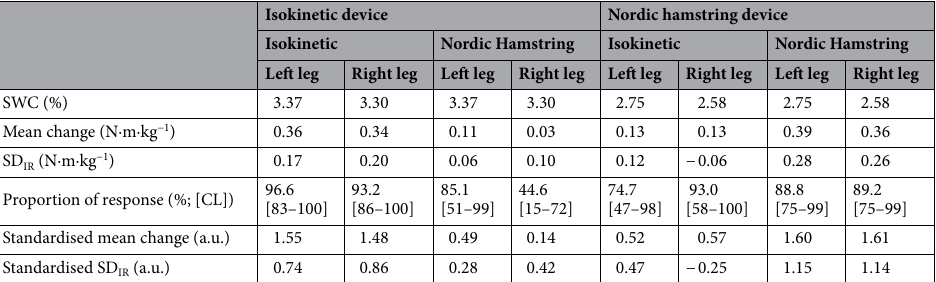
Table 4. Estimation of individual response to isokinetic and Nordic hamstring exercise interventions. SCW, smallest worth change; SDIR, standard deviation of individual response; CL, confidence limits of proportion of response